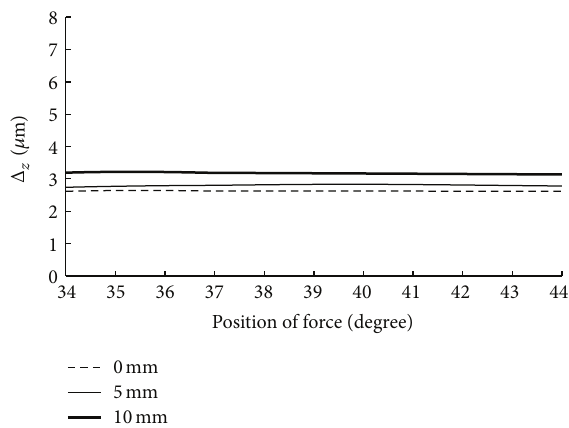
Figure 12: Variation of displacement at z -direction for FCR of Model II under 4